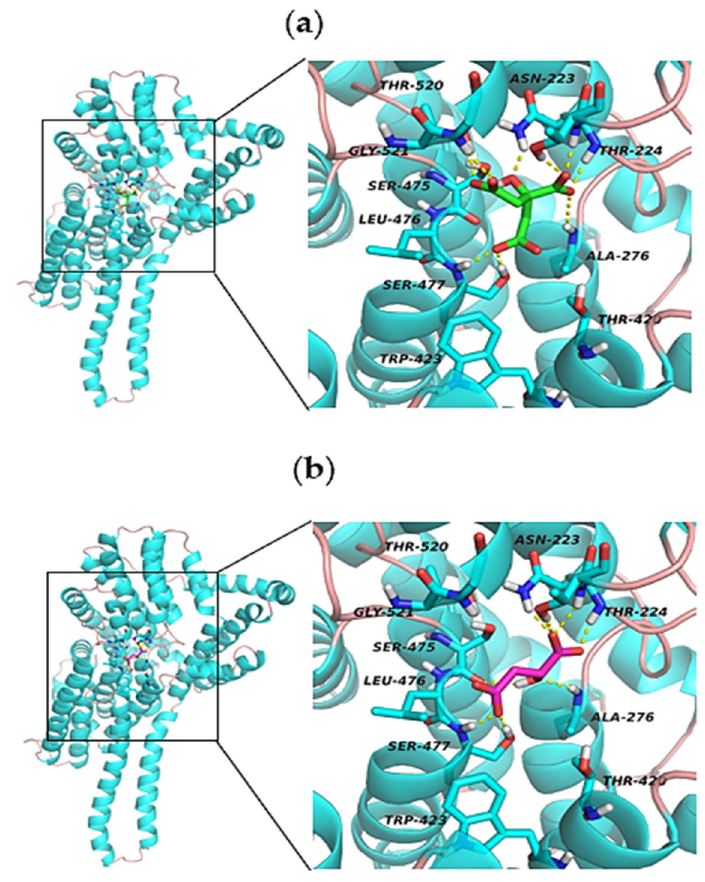
Figure 6. Active site interacting residues of modelled SoDIT-a protein form in the docked structure with ( a ) greenish-blue and green colour ribbons representing modelled SoDIT-a with citric acid, or ( b ) greenish-blue and red colour ribbons representing modelled SoDIT-a with malic acid, respec- tively.